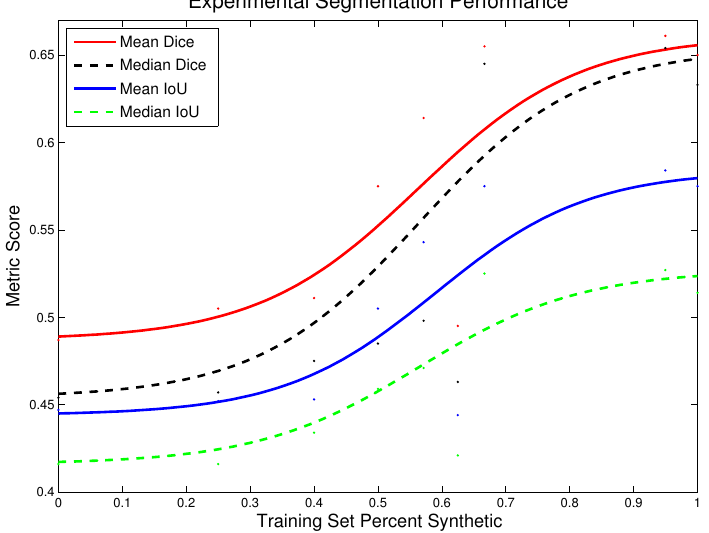
Figure 7. Average Dice and IoU scores for tests on Test Set A as a greater percentage of the training set is composed of synthetically generated endoscopic images using the presented method. Traces are logistic regression fits to the data.